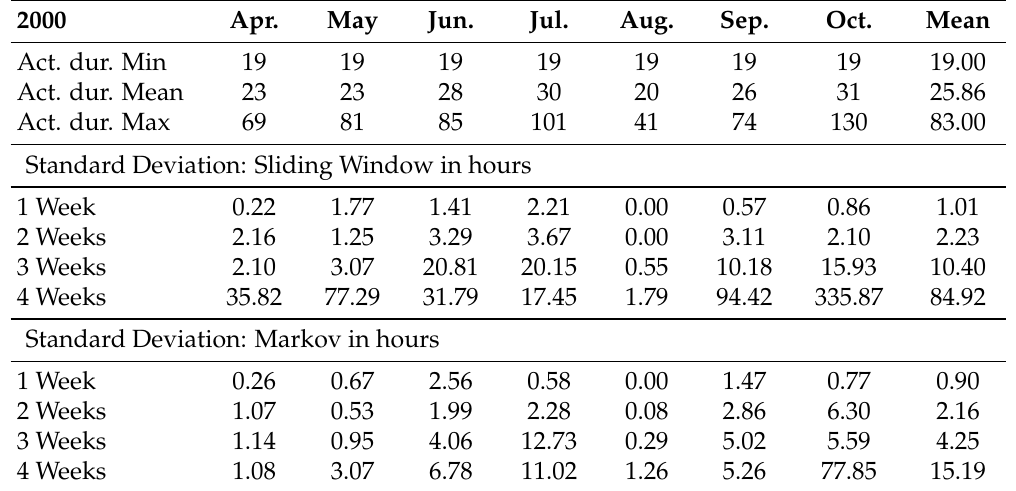
Table 4. Comparison of the sliding window and the Markov approach.